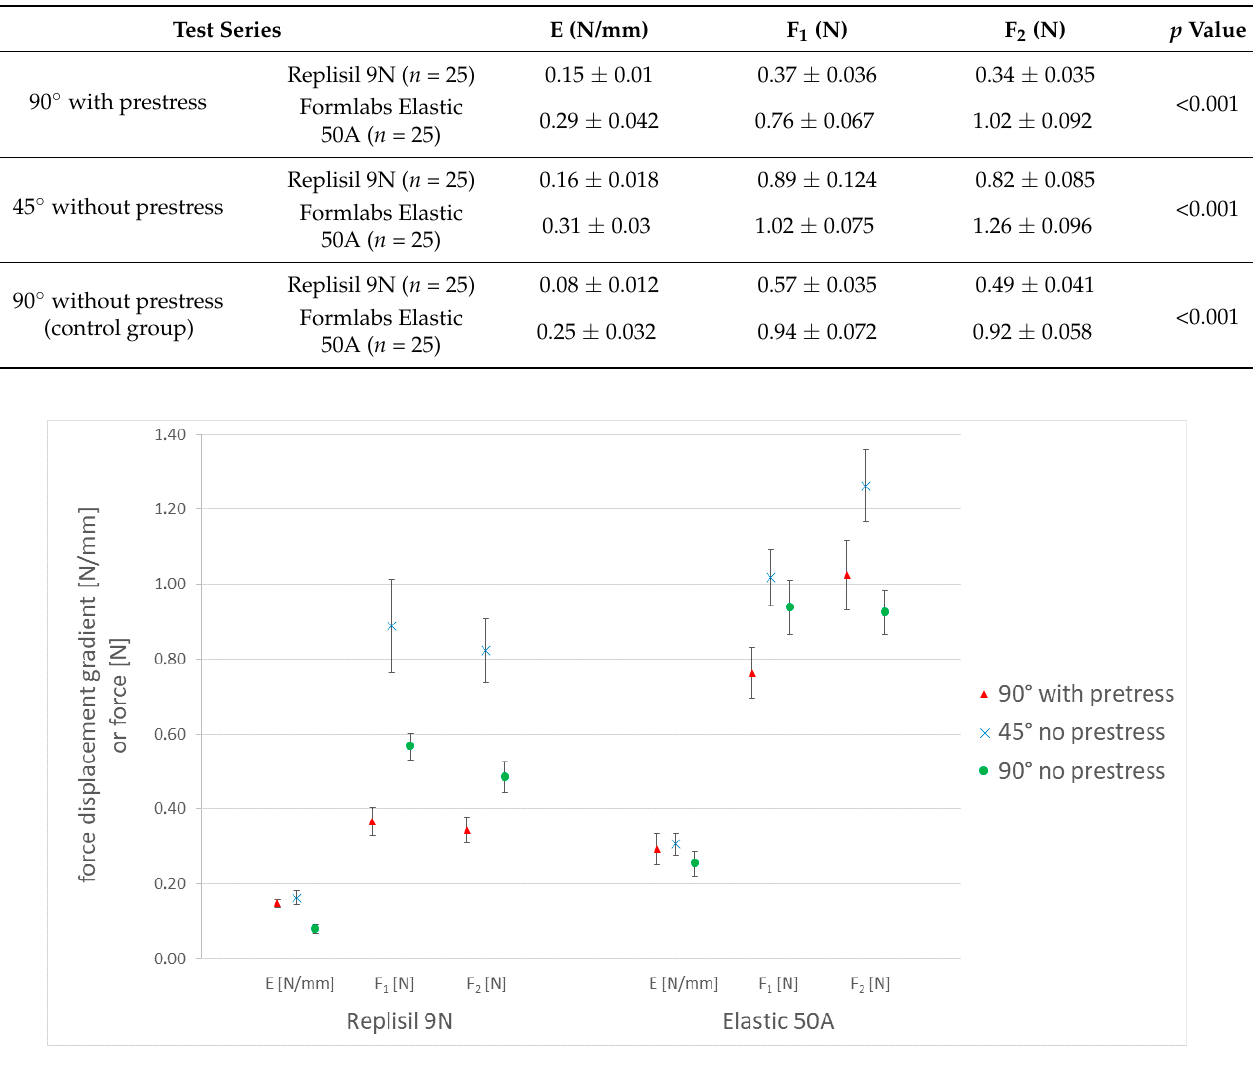
Figure 8. Visualization of the measured means and standard deviations of all three parameters, two materials and three groups. The slope E is in N/mm. The first force maximum F 1 and the following maximum force F 2 are in